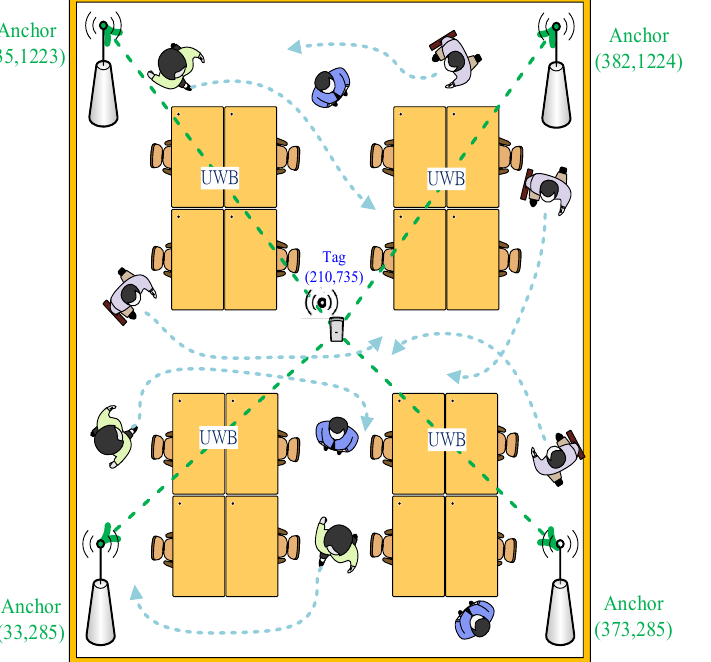
Figure 10. Experimental environment diagram of the people interference point shifting error analysis.